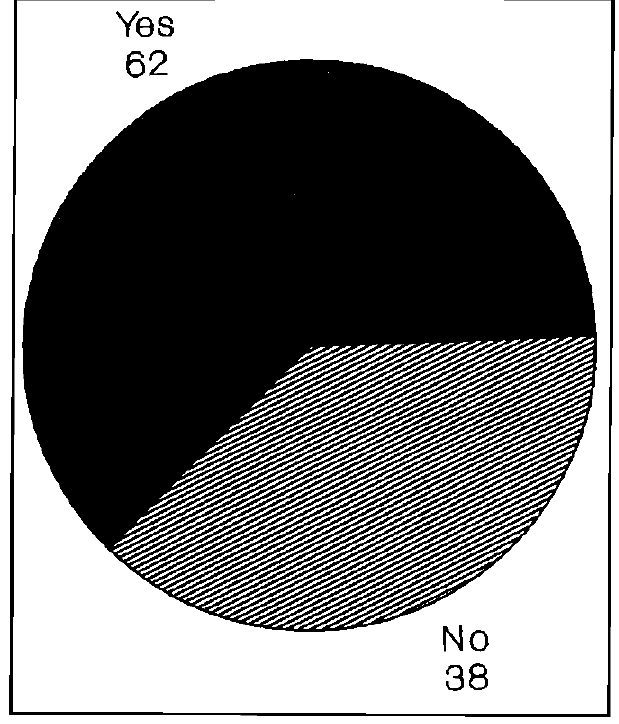
Figure 2. Stress Management Course for Students.